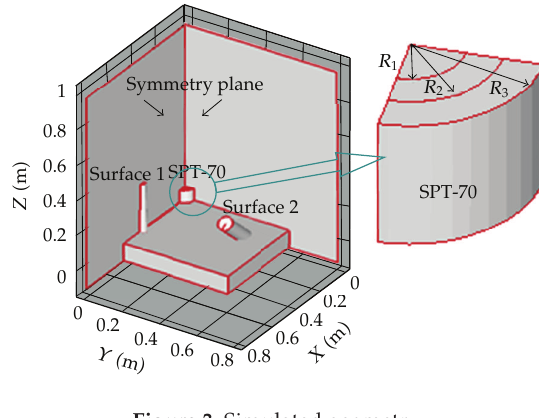
Figure 3: Simulated geometry.